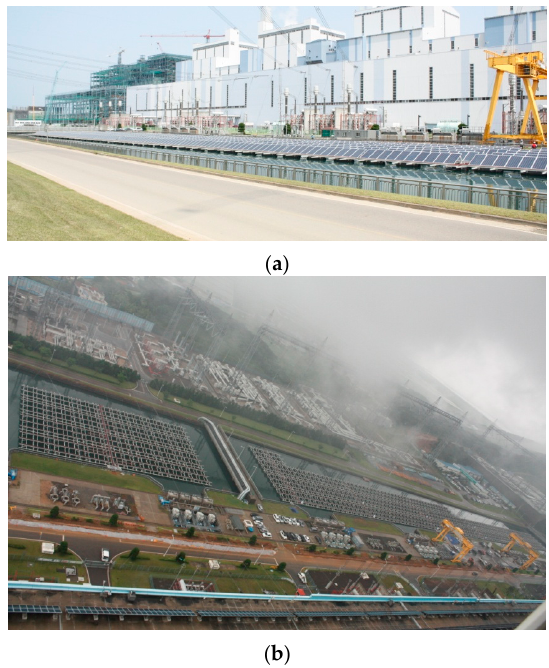
Figure 15. 1 MW class floating PV generation complex; ( a ) Side view; ( b ) Top view.